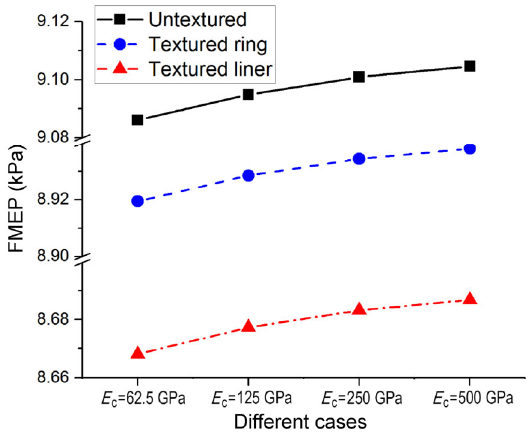
Fig. 7 The variation of FMEP results for the untextured and textured conjunctions under the cold engine condition when different Elasticity modulus of coatings are adopted.